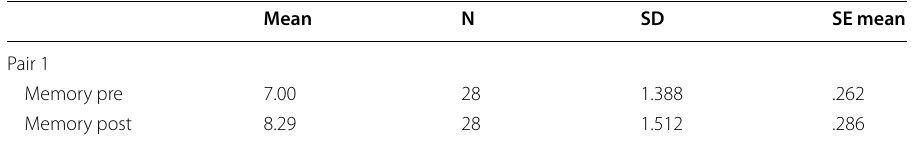
Table 1 Paired samples statistics: memory. Source: SPSS 23.0